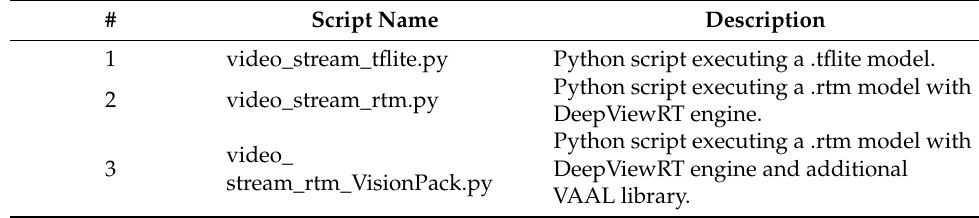
Table 2. Brief explanation of the Python scripts used for testing